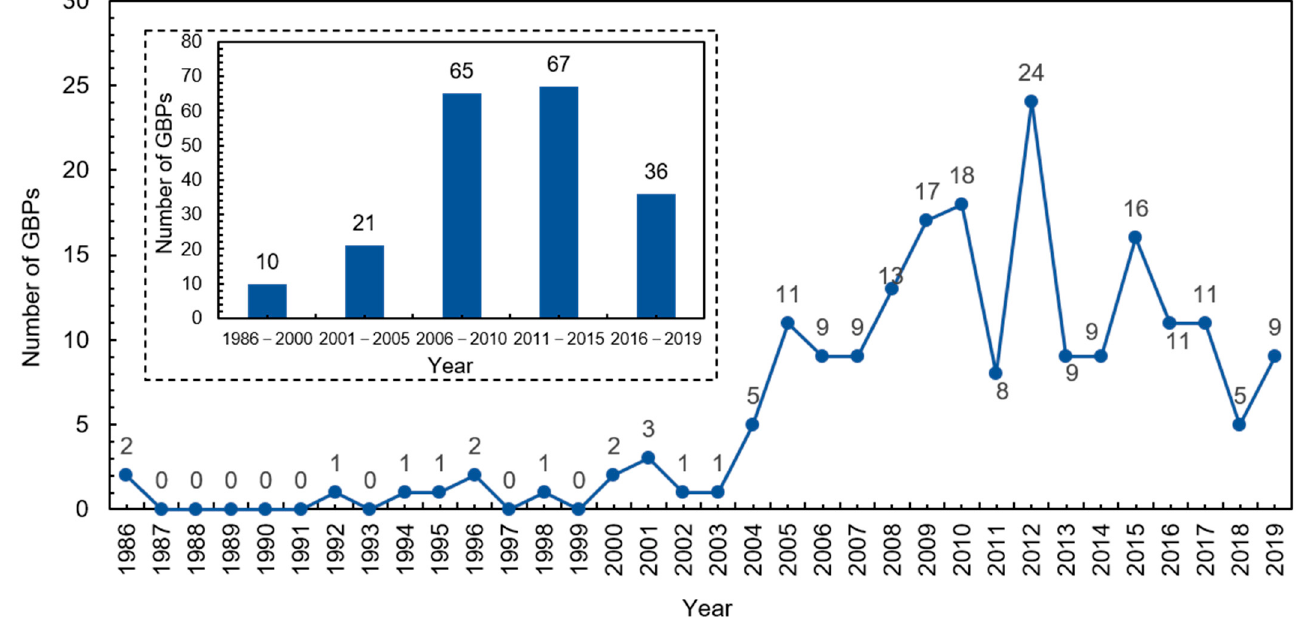
Figure 1. Distribution of China’s green building policies (GBPs) from 1986 to 2019.